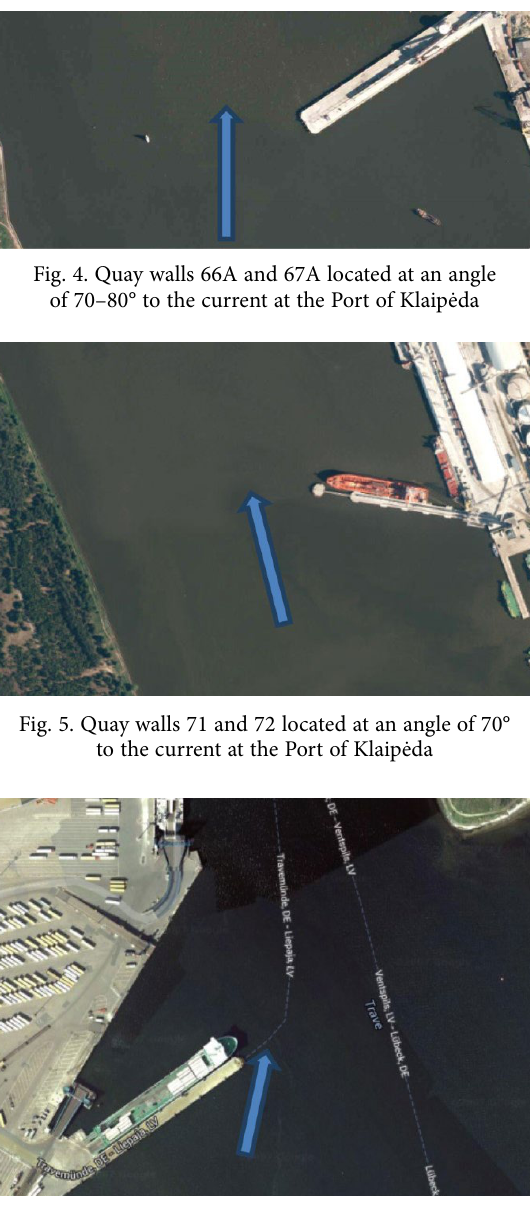
Fig. 6. A ro-ro jetty located at an angle of 50° to the current at the Port of Travemünde